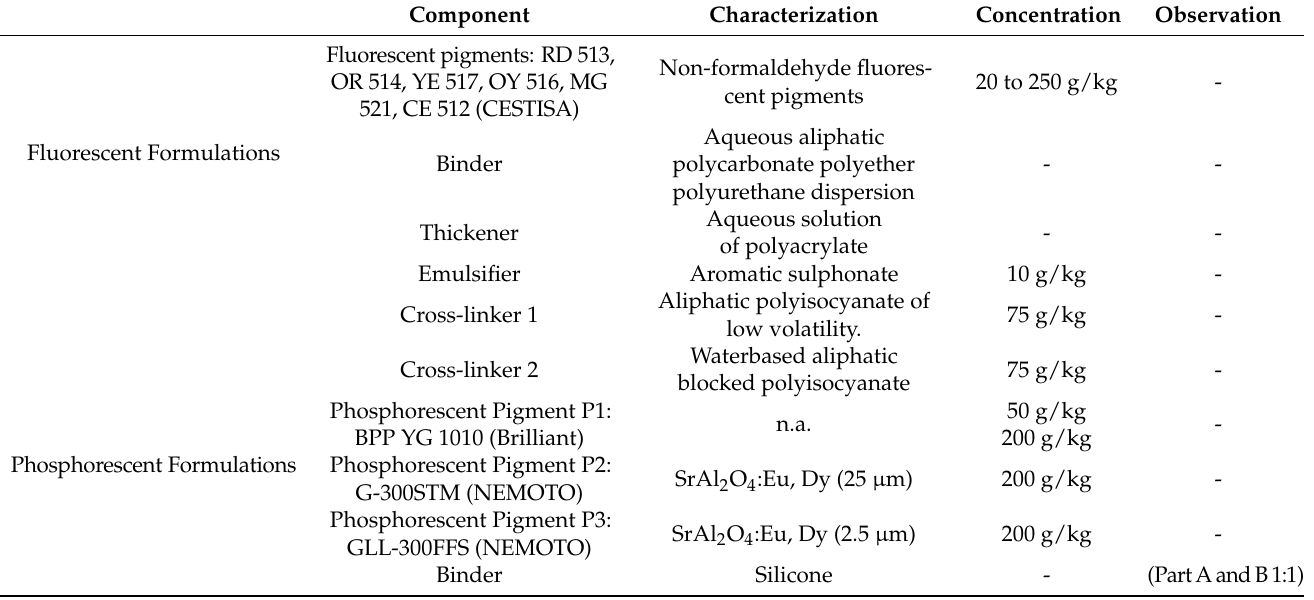
Figure 1. Scheme of application of fluorescent and phosphorescent functional finishings. Table 1. Components used in phosphorescent and fluorescent pigments formulations.